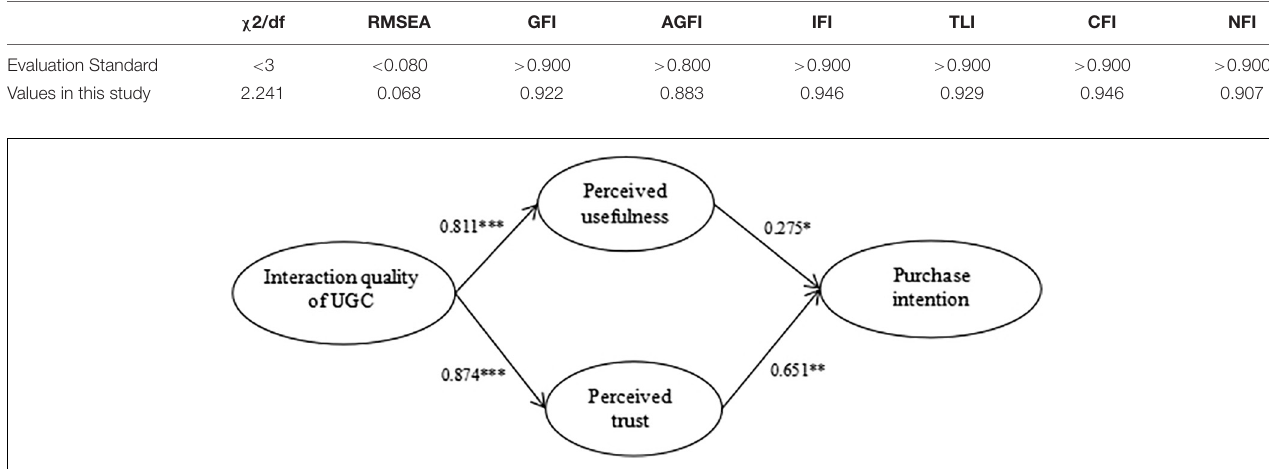
TABLE 3 | Comparison of the theoretical model fit index results with the evaluation standard.